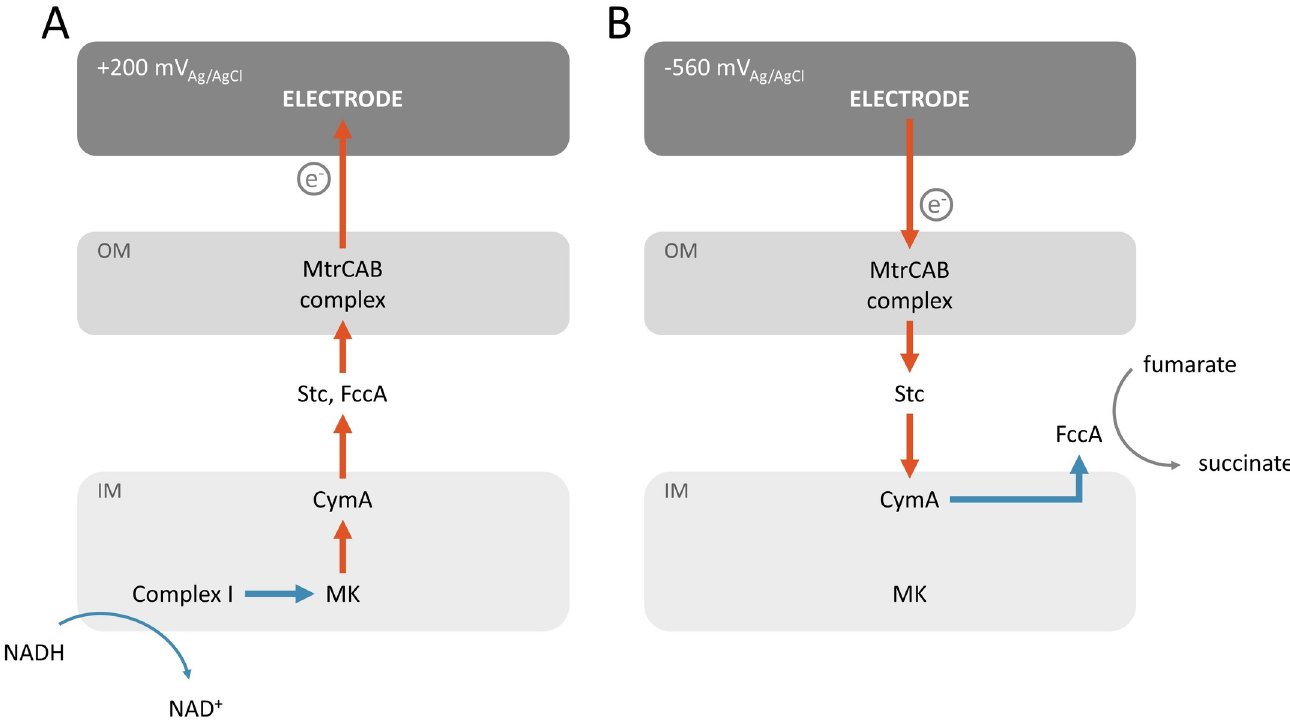
Fig 1. Coupling of intracellular redox reactions to an electrode in Shewanella oneidensis MR-1. Schematic illustrating the role of the MtrCAB complex and the inner membrane cyt c CymA and menaquinone (MK) in the coupling of current production to intracellular oxidation of NADH (A) and current consumption (B) to intracellular reduction of fumarate in S . oneidensis MR-1. (OM: outer membrane, IM: Inner membrane).